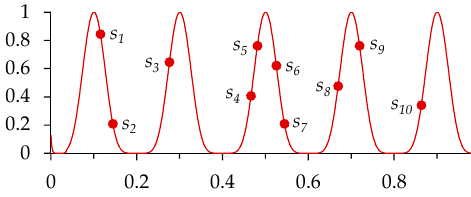
Figure 3. HVF test. It finds 𝑠 (cid:3036) and 𝑠 (cid:3044) in distinct niches if 𝑠 (cid:3039) ( 𝑖 < 𝑙 < 𝑞 ) has less fitness than them.